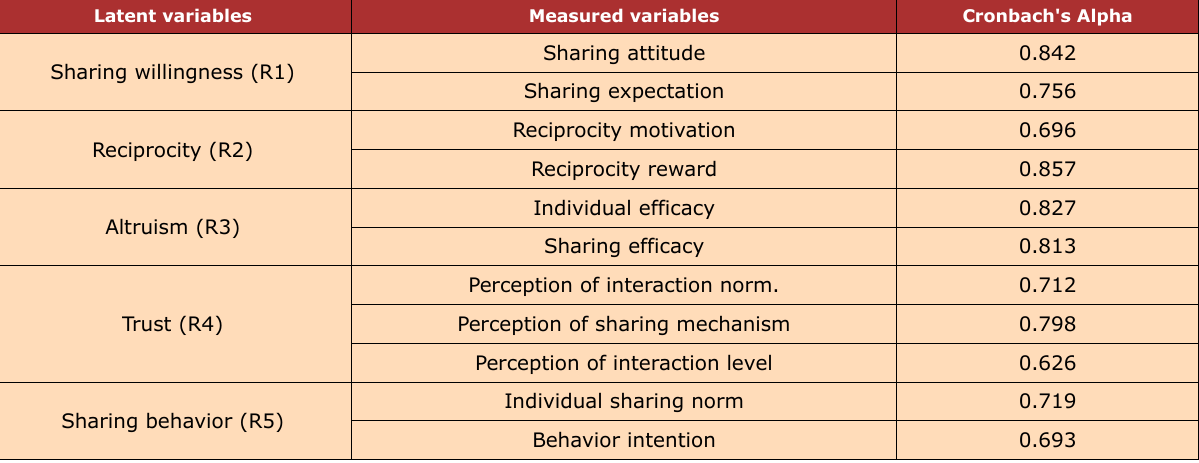
Table 2. Variable and